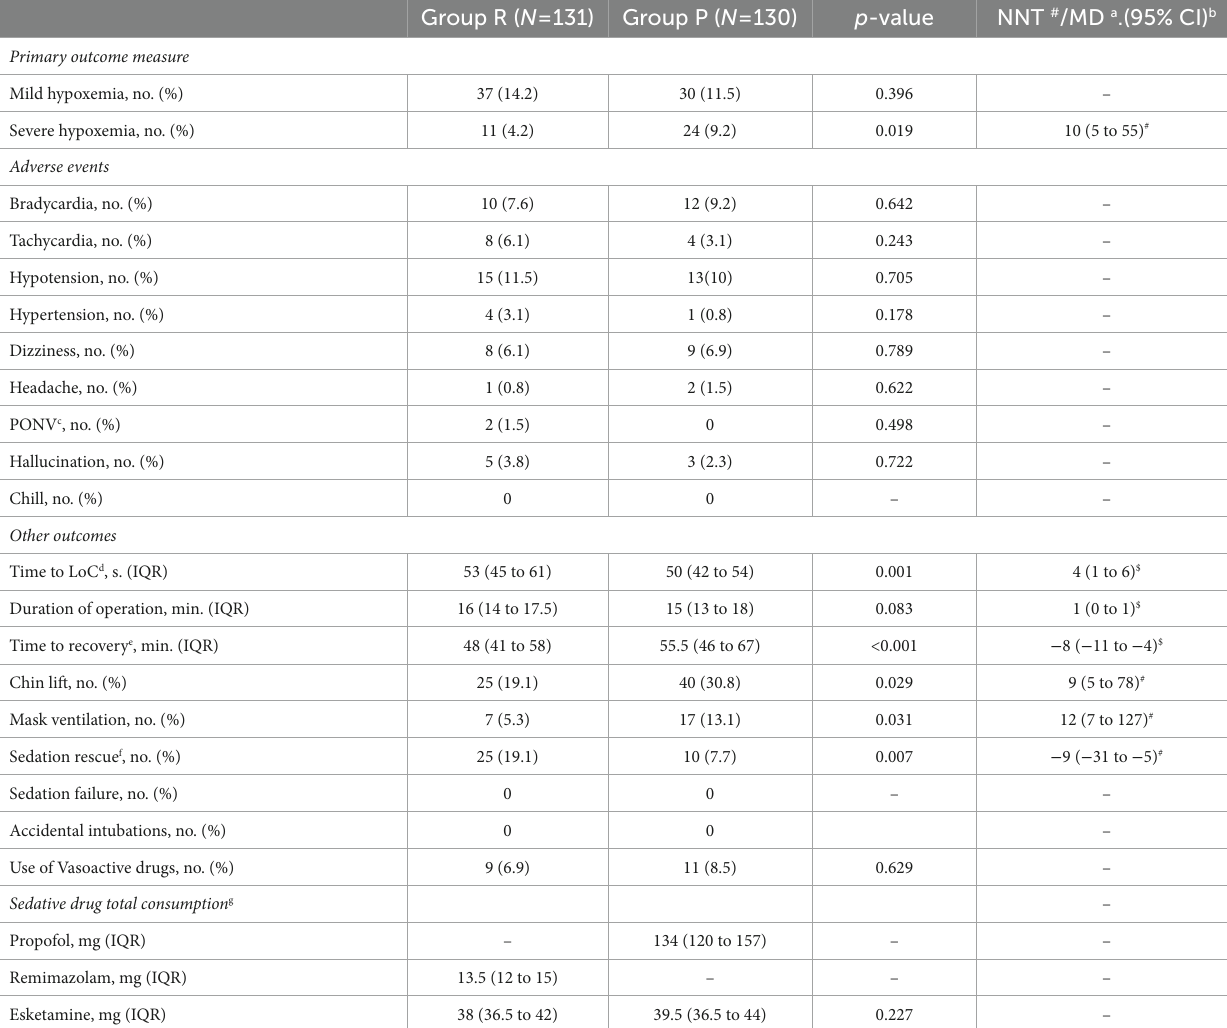
TABLE 2 Procedural characteristics and perioperative outcomes.